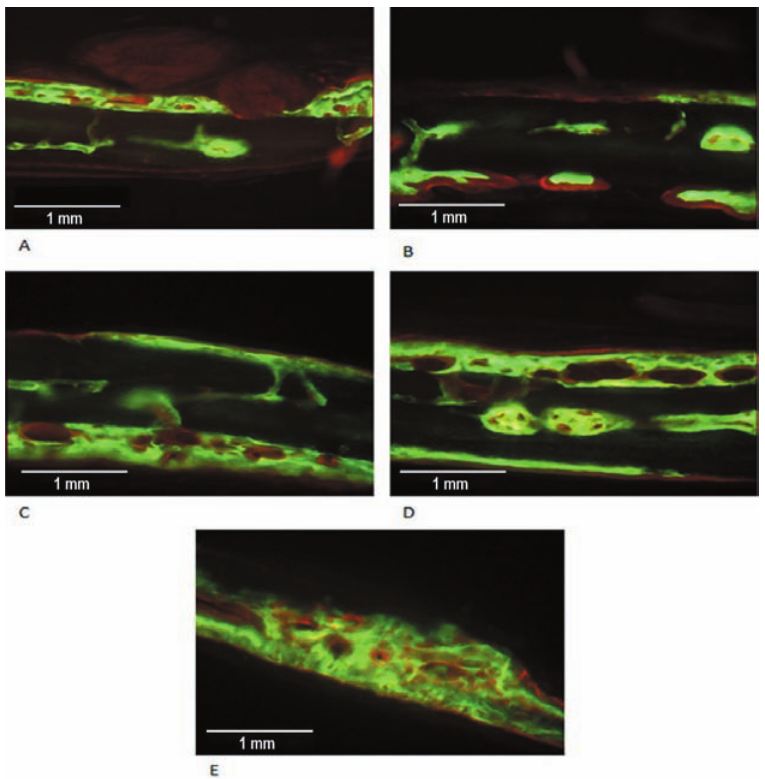
Figure 10- Fluorochrome-labeled areas in the Graft Group. The five animals showed strong labeled areas (green = calcein; red =